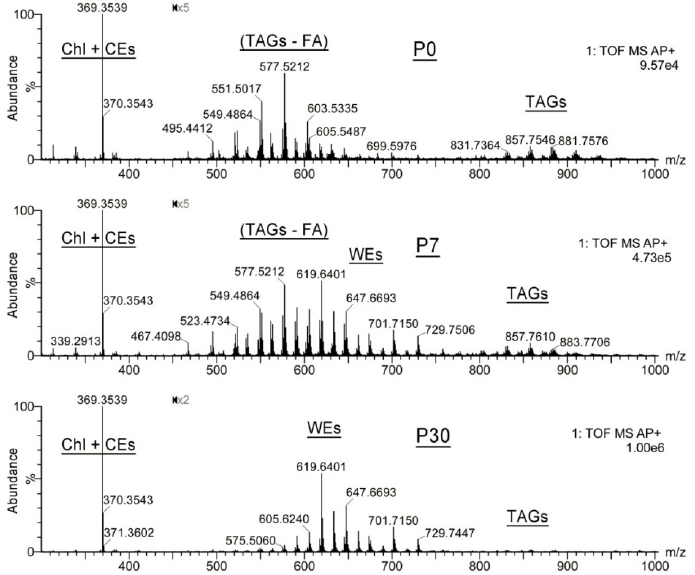
Figure 2. Observation APCI MS PIM spectra of the mouse P0, P7, and P30 Meibomian lipid samples demonstrate a complete lack of typical extremely long-chain Meibomian lipids at P0, and their gradual accumulation in the tarsal plates of maturing mice. The P0 samples were highly enriched with triacylglycerols (detected as intact species and products of their spontaneous in-source fragmentation), free cholesterol, and minor amounts of cholesteryl esters. The P30 sample produced a typical mass spectrum of adult meibum enriched with extremely long-chain wax and cholesteryl esters. The P7 sample assumes an intermediate position between P0 and P30 samples. Note that the regions of the graphs between m/z 450 and m/z 1000 were magnified 2 to 5 times for clarity.